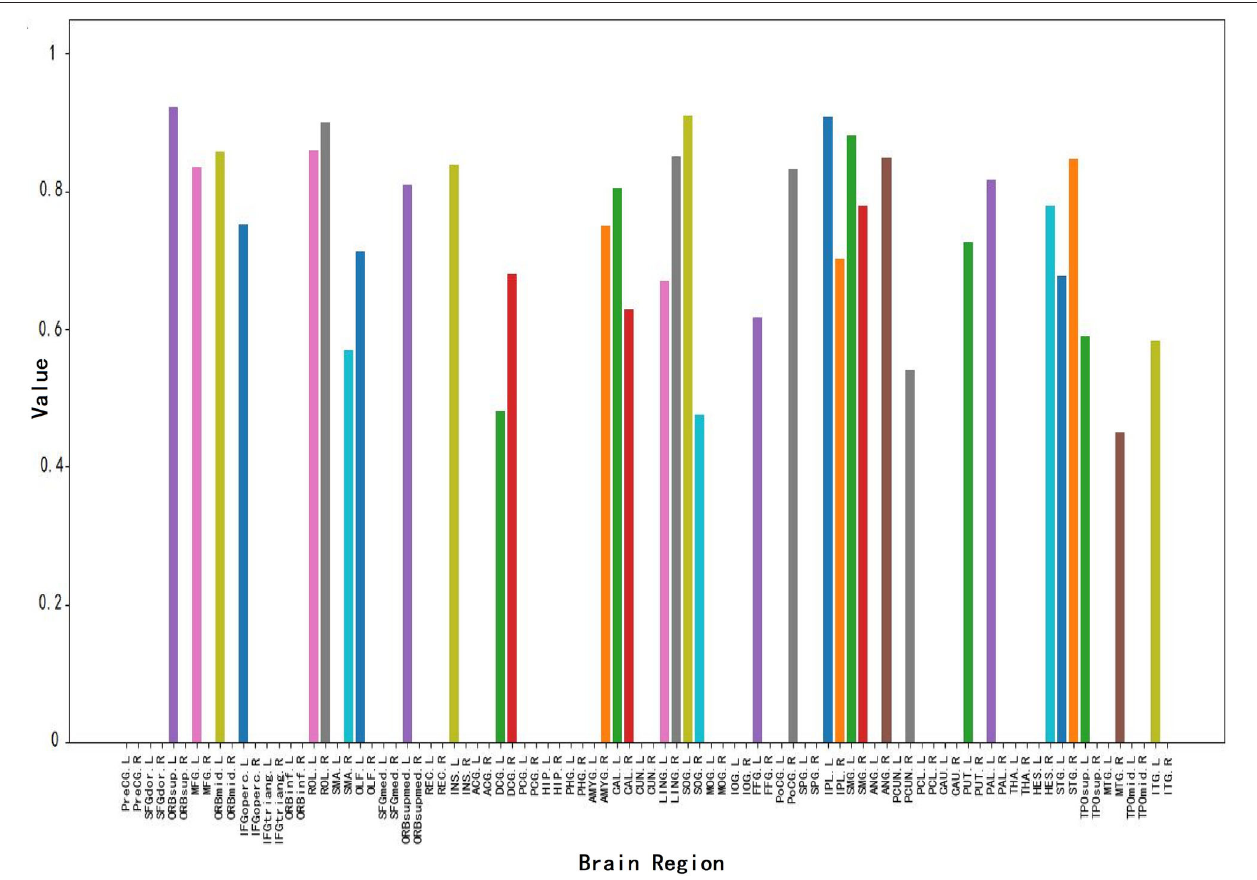
FIGURE 6 | Visualization of brain node attention